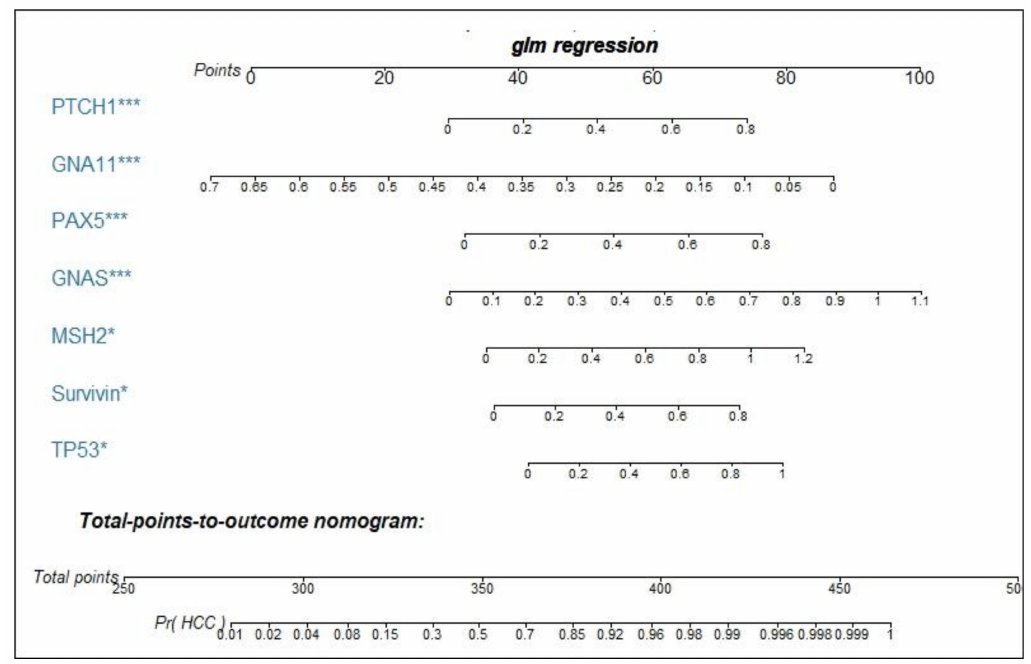
Figure 3. Nomogram for predicting the probability of HCC. As an example, locate the patient’s OD value of anti-PTCH autoantibody and draw a line straight up to the “points” axis to determine the score associated with this indicator. Add the scores achieved for each anti-TAA autoantibody, and locate this sum on the “total points” axis. Draw a line straight down to determine the probability of HCC.